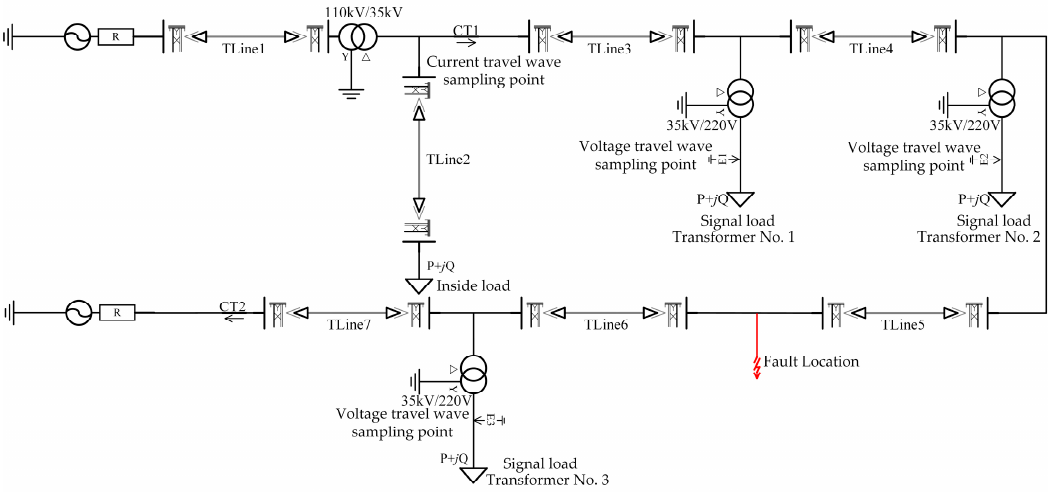
Figure 7. Model of simulation.